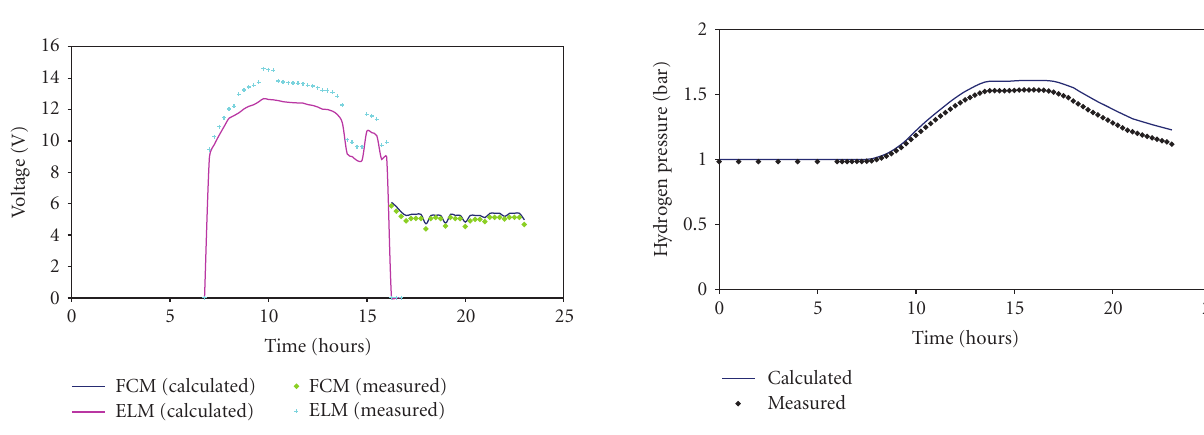
DC/DC controls the voltage to the desired load amount.